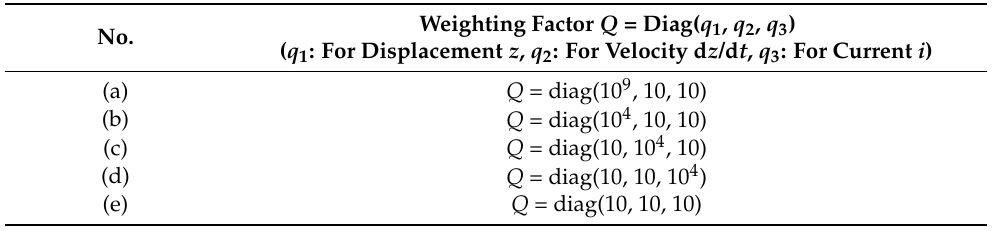
Table 1. Weighting factors for the